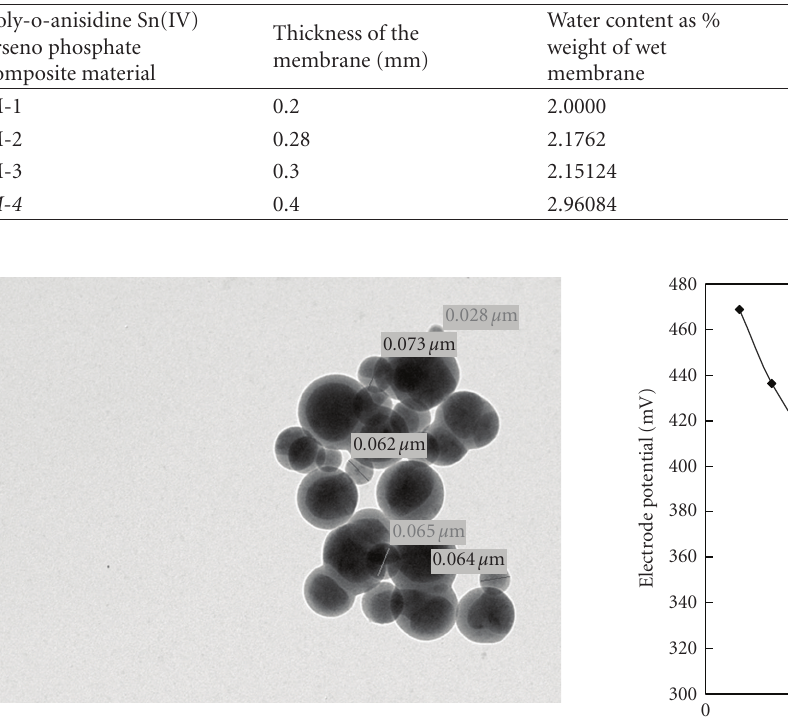
Figure 5: TEM Micrographs of Poly-o-anisidine Sn(IV)